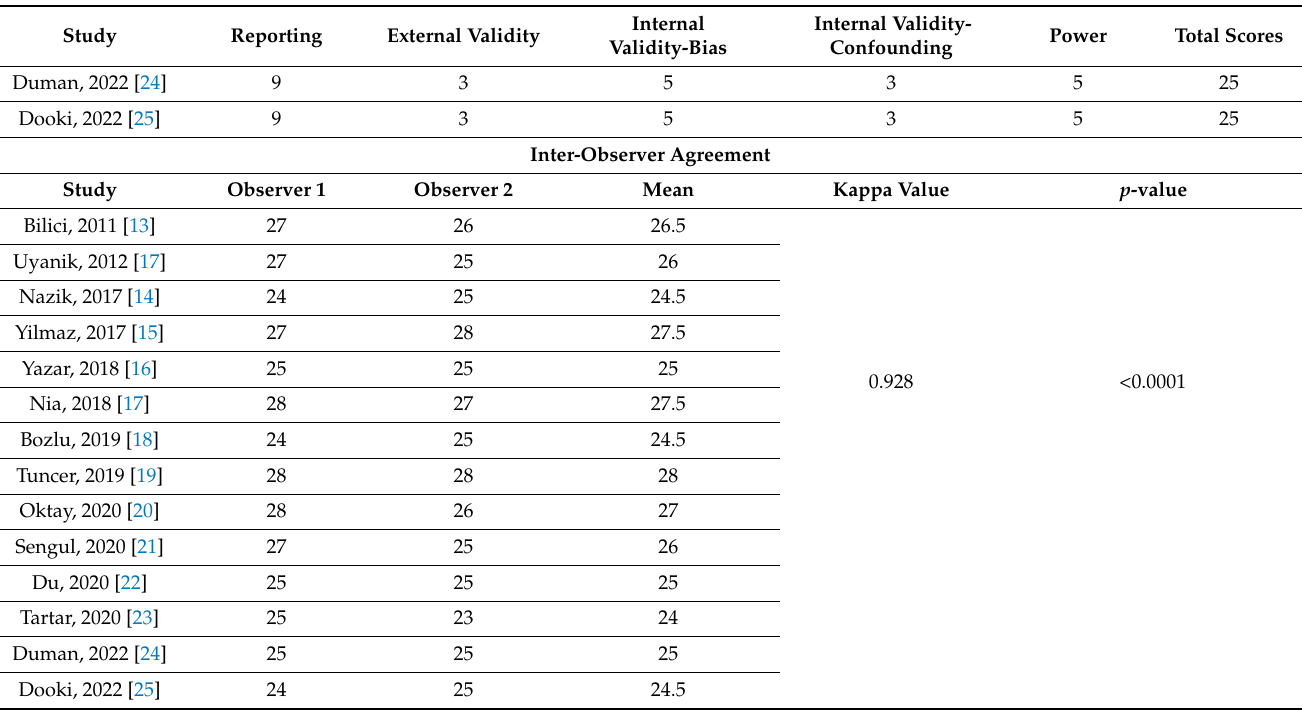
Figure 3. Forest plot comparison between the two patient groups (AA versus non-AA) in terms of the average values of mean platelet volume. Abbreviations: AA, acute appendicitis; non-AA, non- acute appendicitis; IV, inverse variance; CI, confidence interval. 4. Discussion Acute appendicitis presents challenges, and alternative methods for diagnostic veri- fication are ongoing. While severe appendicitis is treated by appendectomy, the treatment choices for the mild disease remain pendent, and some cases may resolve without any intervention [26]. It has been suggested that complicated and uncomplicated appendicitis are at the very ends of the disease spectrum and may even be considered different diseases [27]. Especially in children, a significant proportion of patients presenting with lower ab- dominal pain do not have AA. Nevertheless, those who have may progress to complicated appendicitis rapidly, underlining the importance of correct diagnosis for appropriate